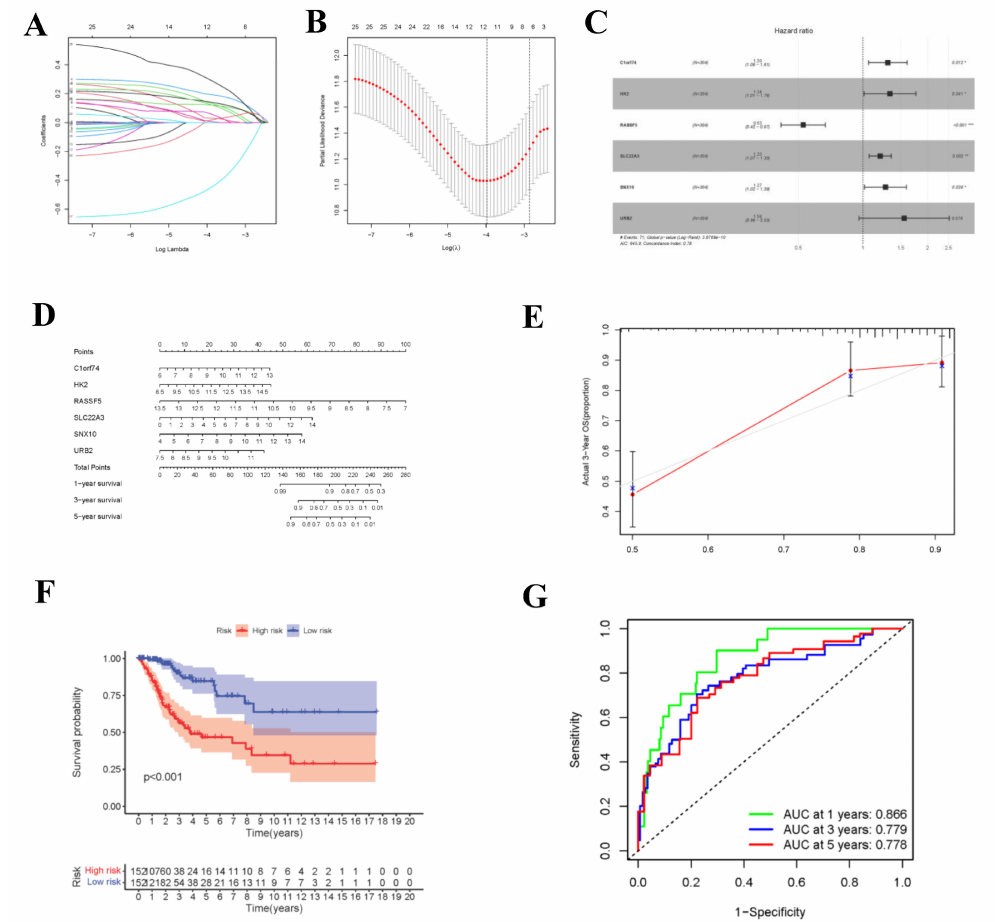
Figure 6. Construction of circ-related prognosis model. ( A , B ) The results of lasso regression analysis results. ( C ) Forest plot shows prognostic circ-related mRNA signatures of CC. Six potential prognosis related RNAs were integrated into the Cox proportional hazards regression model (* p < 0.05; ** p < 0.01; *** p < 0.001). The nomogram ( D ) was constructed based on the model. The ROC ( G ) and calibration curves ( E ) indicate the acceptable accuracy (AUCs of 1, 3, and 5-year survivals: 0.866, 0.779, and 0.778) and discrimination of the nomogram. ( F ) OS of patients with high/low-risk